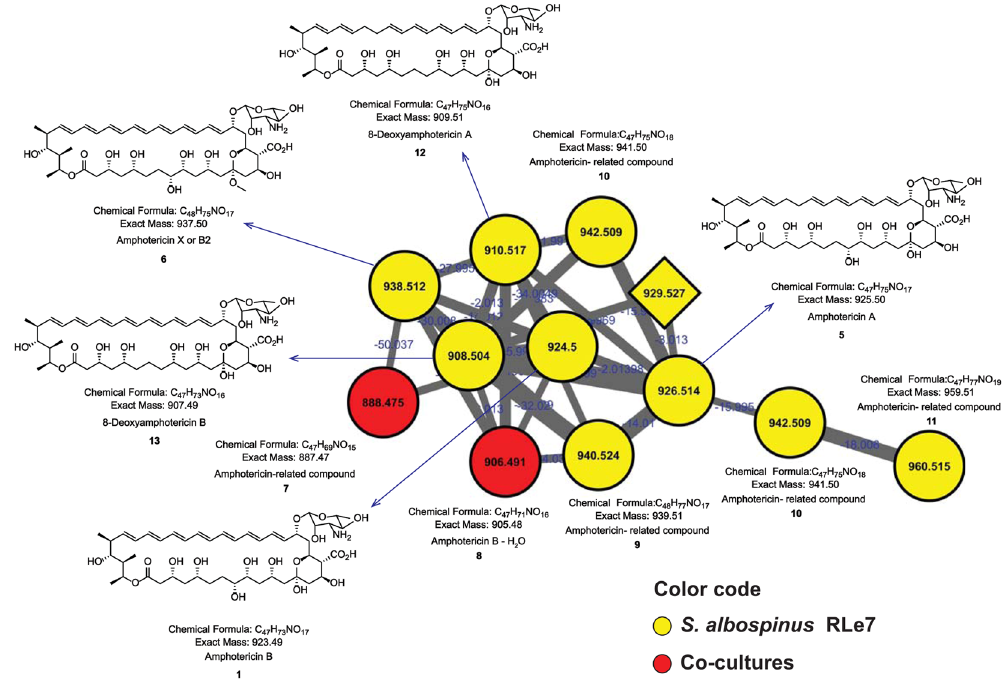
Figure 3. Amphotericin-cluster from the molecular network of interactions among endophytic microorganisms from L . ericoides . Nodes from co-cultures are red, nodes observed only in mono-cultures are differentiated by a diamond shape, nodes originated from S . albospinus RLe7 in mono- and co-cultures are yellow and round